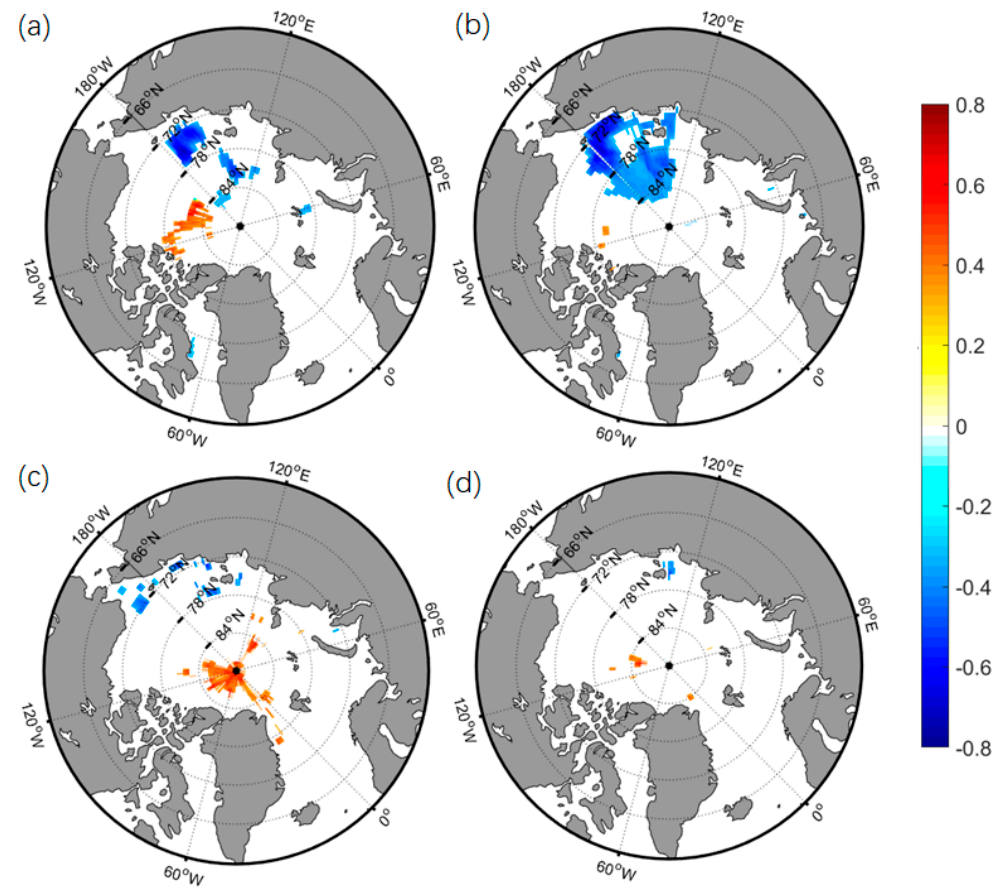
Figure 3. The correlation coefficient distribution between the winter precipitation of the Barents–Kara Sea and the autumn sea ice in August ( a ), September ( b ), October ( c ), and November ( d ). All the data have been de-trended.